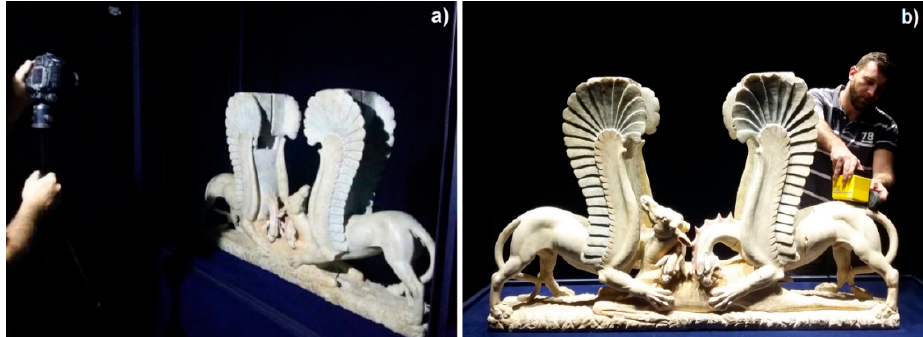
Figure 1. The acquisition of images with a reflex Nikon D80 ( a ) and a ground-penetrating radar (GPR) survey with an IDS-RIS K2 instrument equipped with a 1200-MHz antenna ( b ).